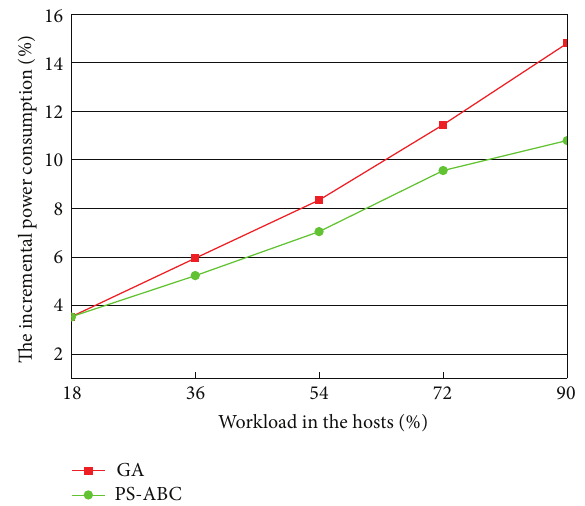
Figure 7: Comparison of the incremental power consumption in the cloud data center with varying percentage of load.